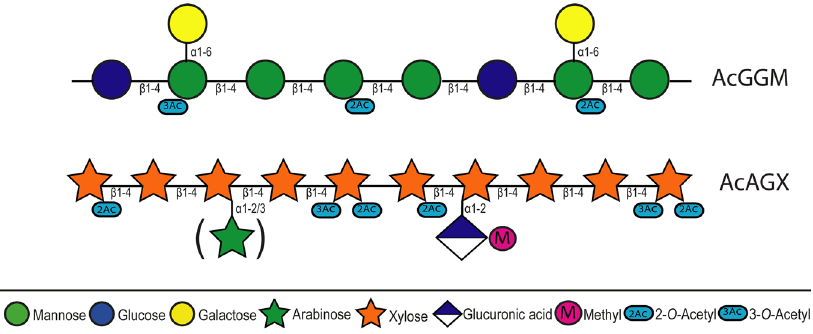
Fig. 1 Schematic of substrates used in this study. Acetylated galactoglucomannan (AcGGM) from Norwegian spruce wood and acetylated (arabino) glucuronoxylan (AcAGX) from Norwegian birch wood (very small amount of